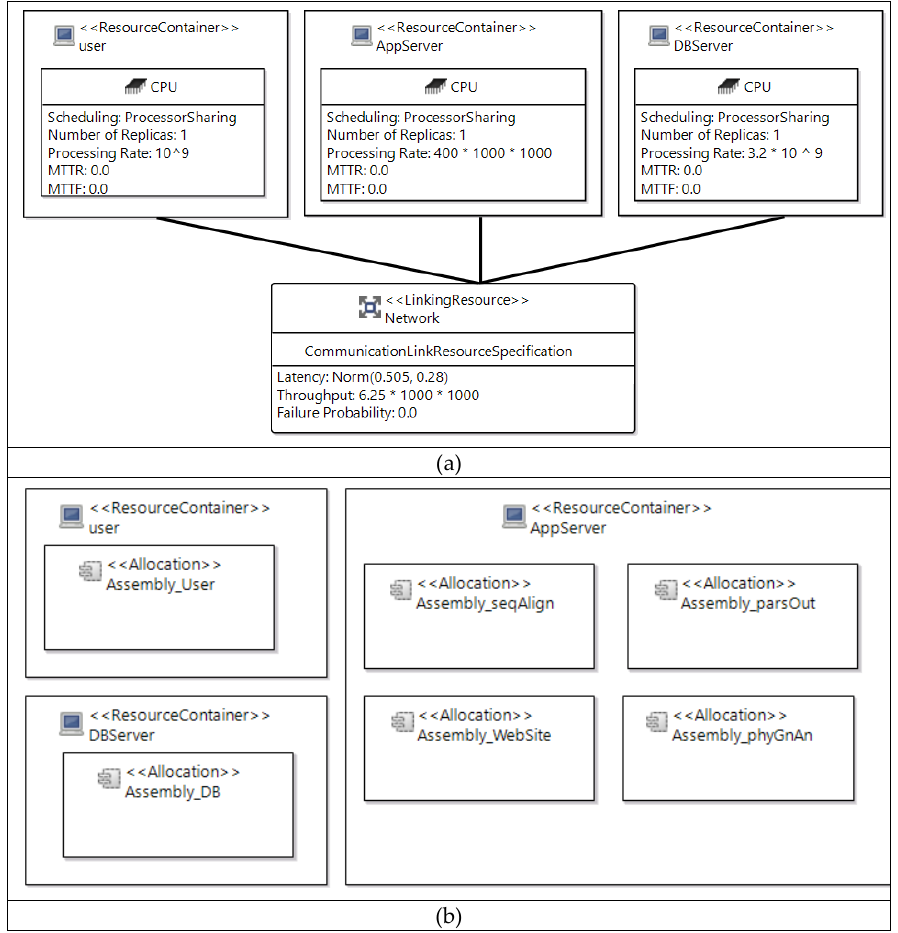
Figure 7. Deployment of components in the resource environment: ( a ) resource environment diagram; ( b ) allocation diagram.